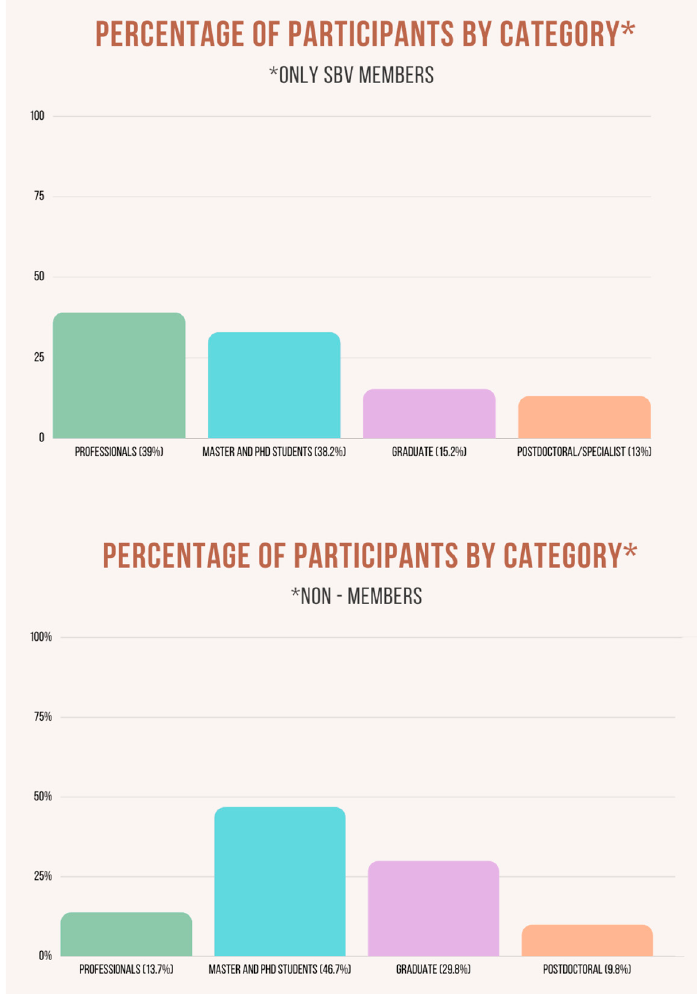
Figure 2. Percentage of attendees by categories. Panel superior shows attendees members of the SBV society and panel inferior the non-members attendees. * for SBV members in left panel and non-members in right panel.